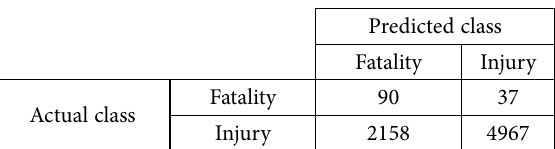
Table 5. Classification matrix for the fatality and injury victims of road accidents in the case of a pruned tree